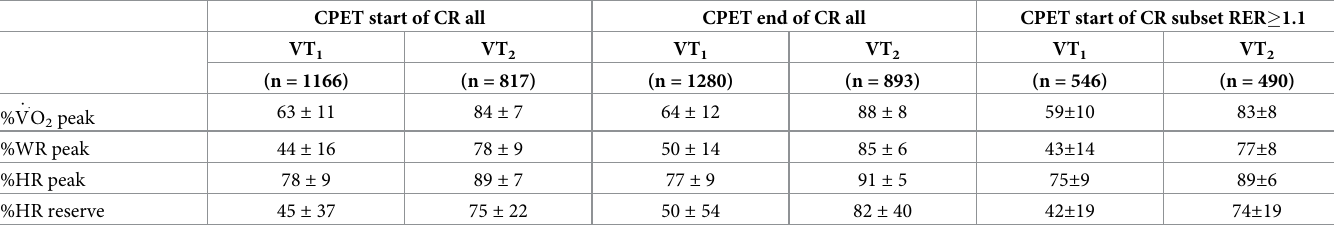
Table 1. First and second individual ventilatory thresholds at start and end of CR relative to peak exercise. CPET start of CR all CPET end of CR all CPET start of CR subset RER � 1.1 VT 1 VT 2 VT 1 VT 2 VT 1 VT 2 (n = 1166) (n = 817) (n = 1280) (n = 893) (n = 546) (n = 490) % _ V _ O 2 peak 63 ± 11 84 ± 7 64 ± 12 88 ± 8 59 ± 10 83 ± 8 44 ± 16 78 ± 9 50 ± 14 85 ± 6 43 ± 14 77 ± 8 %HR peak 78 ± 9 89 ± 7 77 ± 9 91 ± 5 75 ± 9 89 ± 6 45 ± 37 75 ± 22 50 ± 54 82 ± 40 74 ±